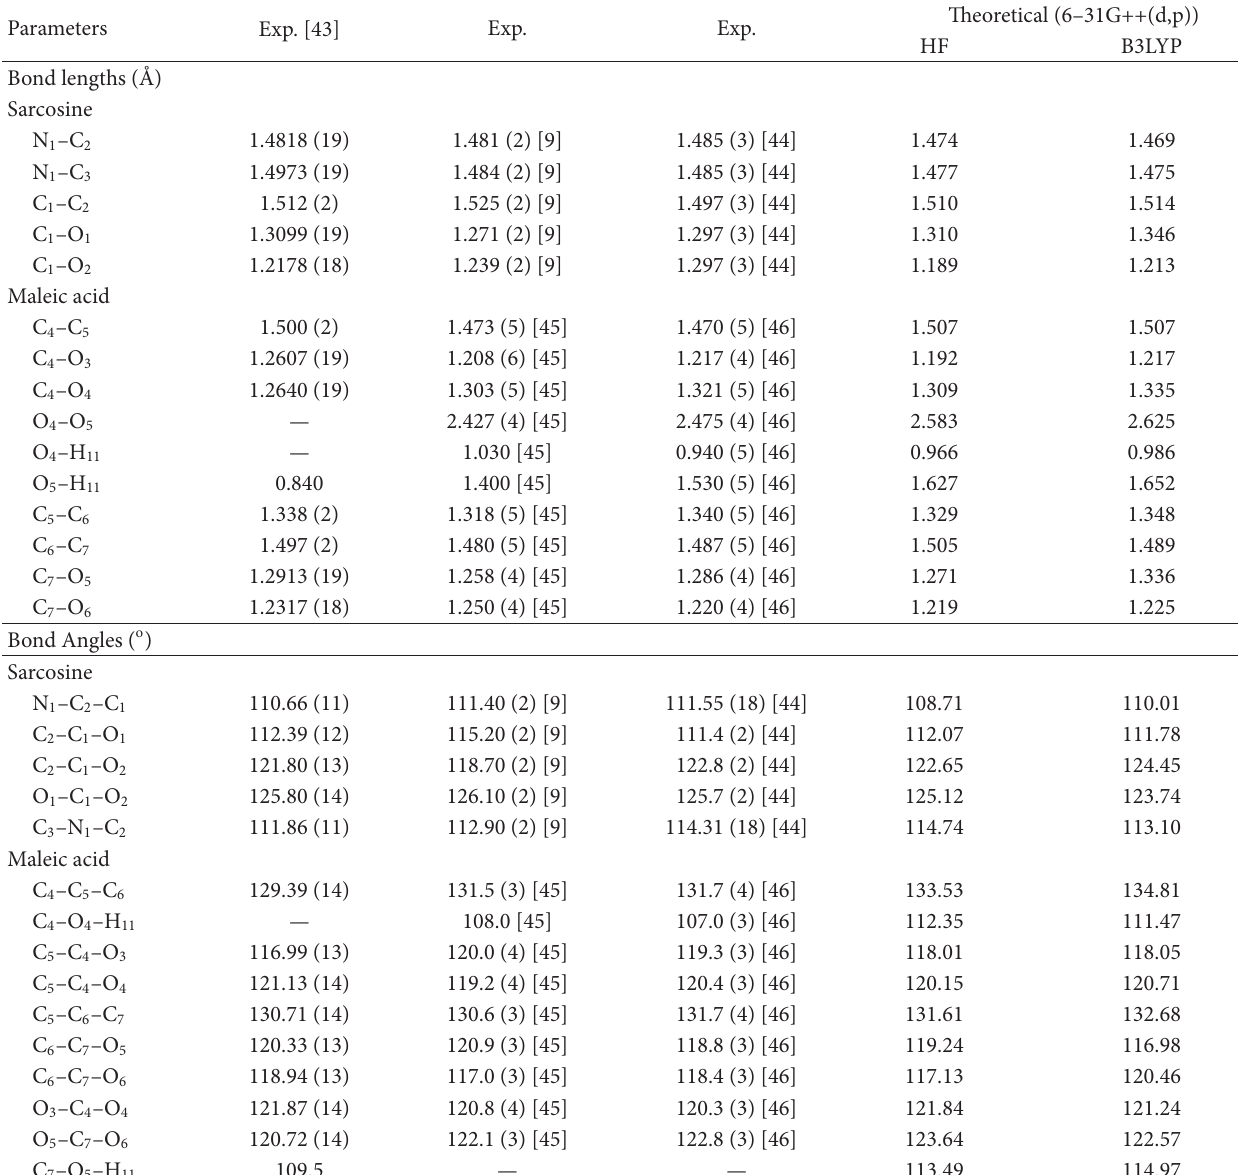
T 1: Selected experimental and theoretical bond lengths and angles for sarcosine-maleic